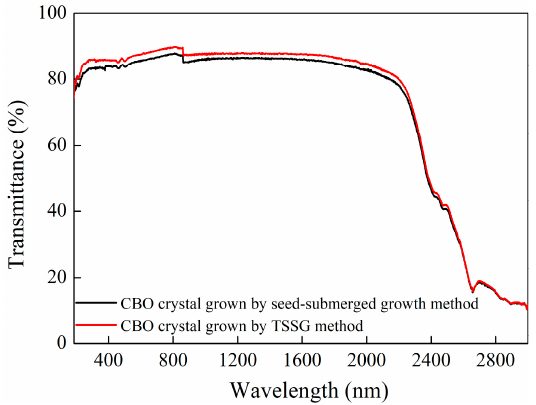
Figure 5. Transmission spectra of CBO crystals grown via the seed-submerged growth method and the TSSG method.